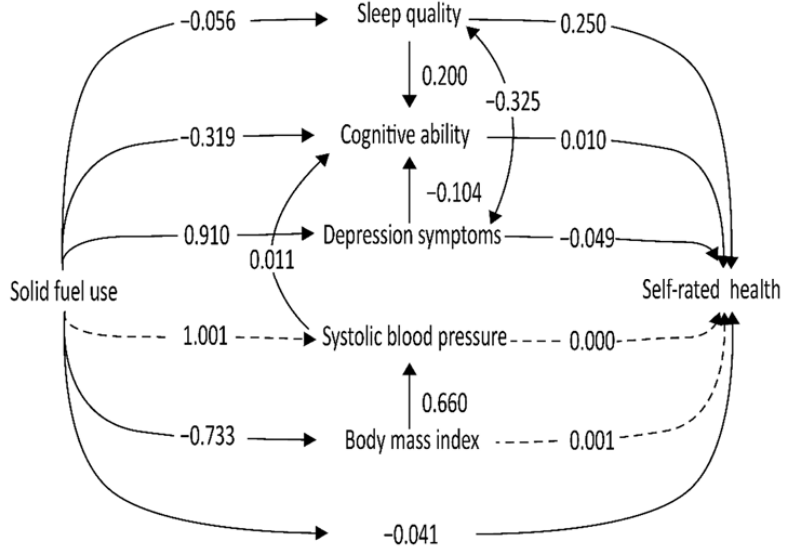
Figure 2. Pathways between solid fuel, mediators, and self-rated health, according to the Chinese Longitudinal Healthy Longevity Survey, 2018. Structural equation modeling was performed among Chinese older adults over 65 years old. The model was adjusted for age, sex, marital status, commu- nity location, education years, household income, smoking status, alcohol use, and physical exercise. Dashed lines denote insignificant pathways between solid fuel, mediators, and self-rated health, while solid lines denote significant pathways between solid fuel, mediators, and self-rated health. Table 2. Direct, indirect, and total effects of solid fuel use on self-rated health.